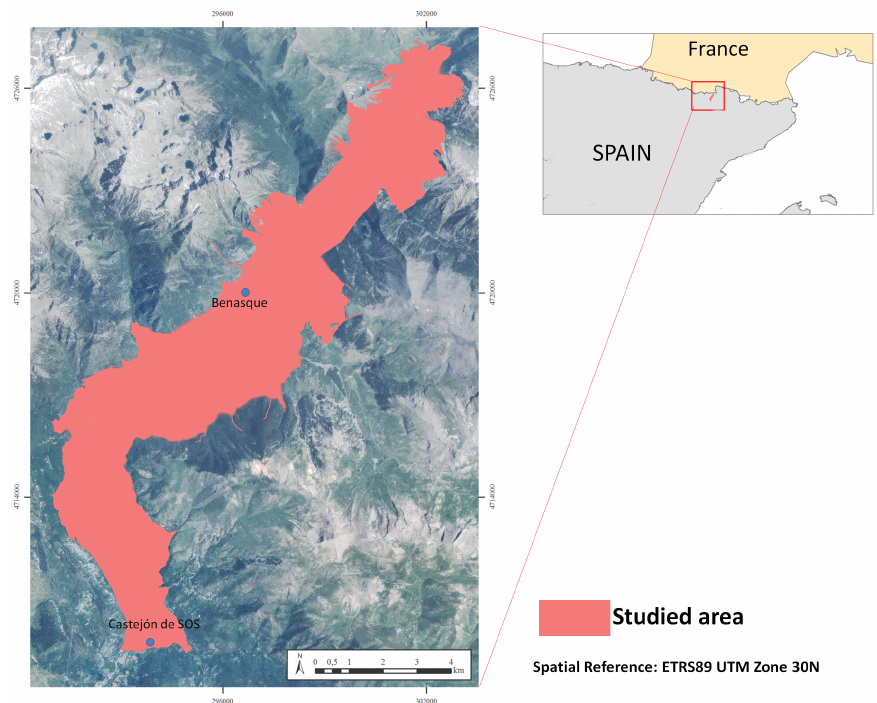
Figure 1. Location of studied